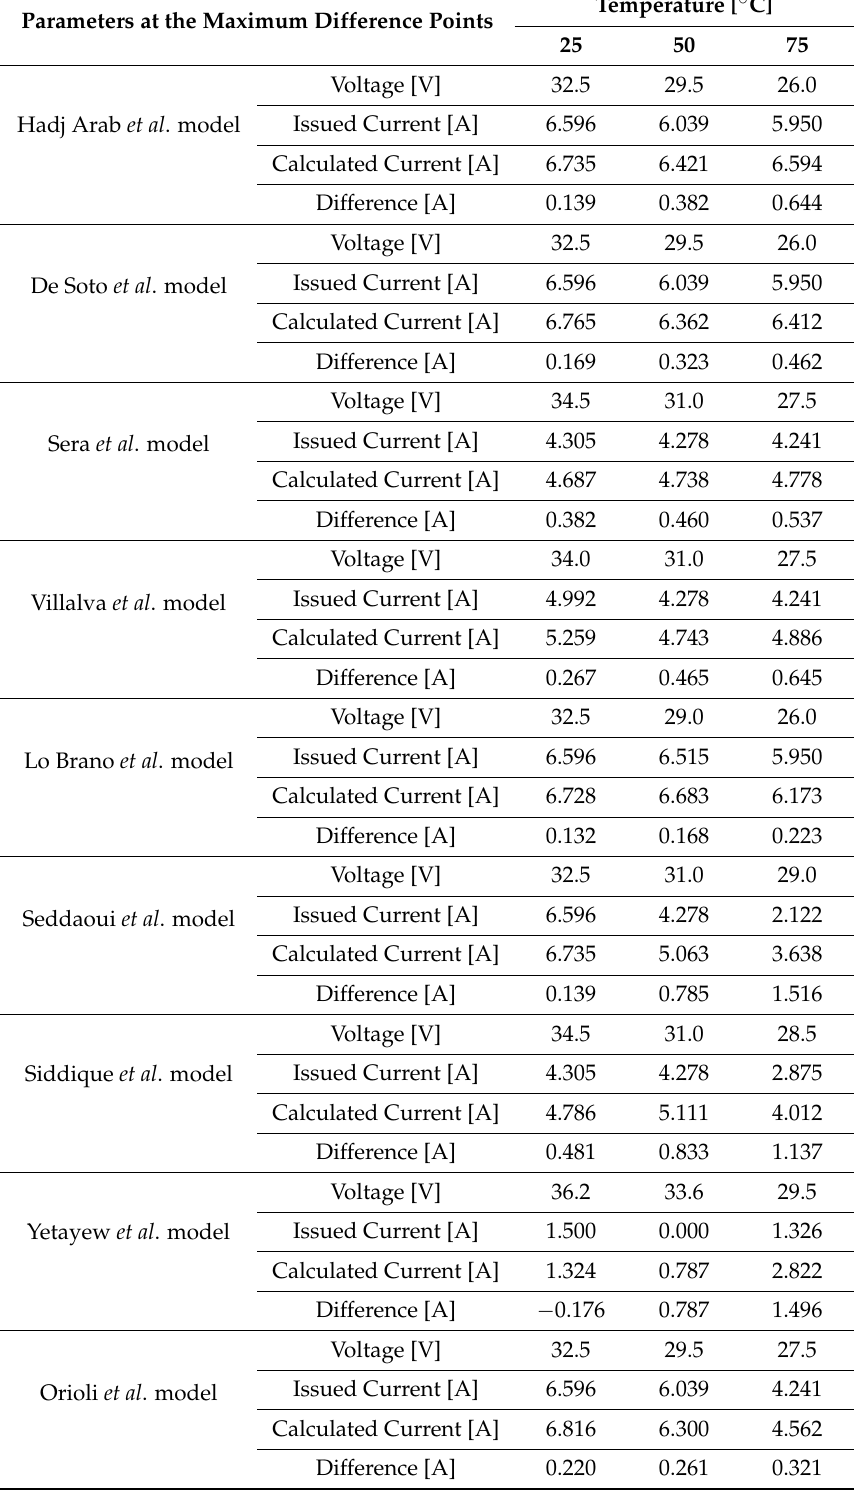
Parameters at the Maximum Difference